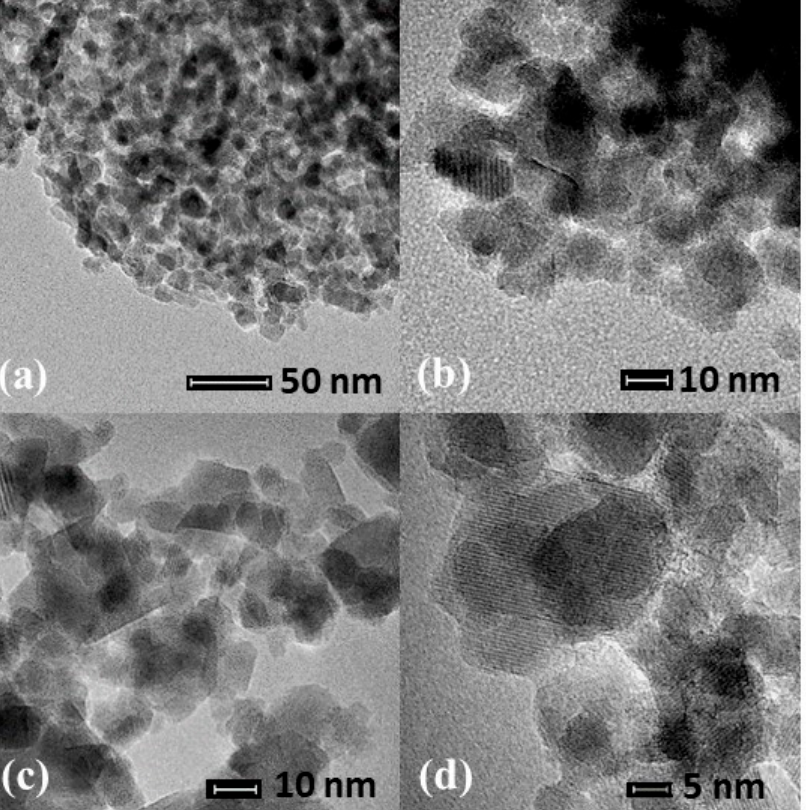
Figure 4. Transmission electron microscopy (TEM) of samples ( a ) ZnAl 2 O 4 –750; ( b ) NiAl 2 O 4 –950; ( c ) CoAl 2 O 4 –750; ( d ) NiAl 2 O 4 –950.